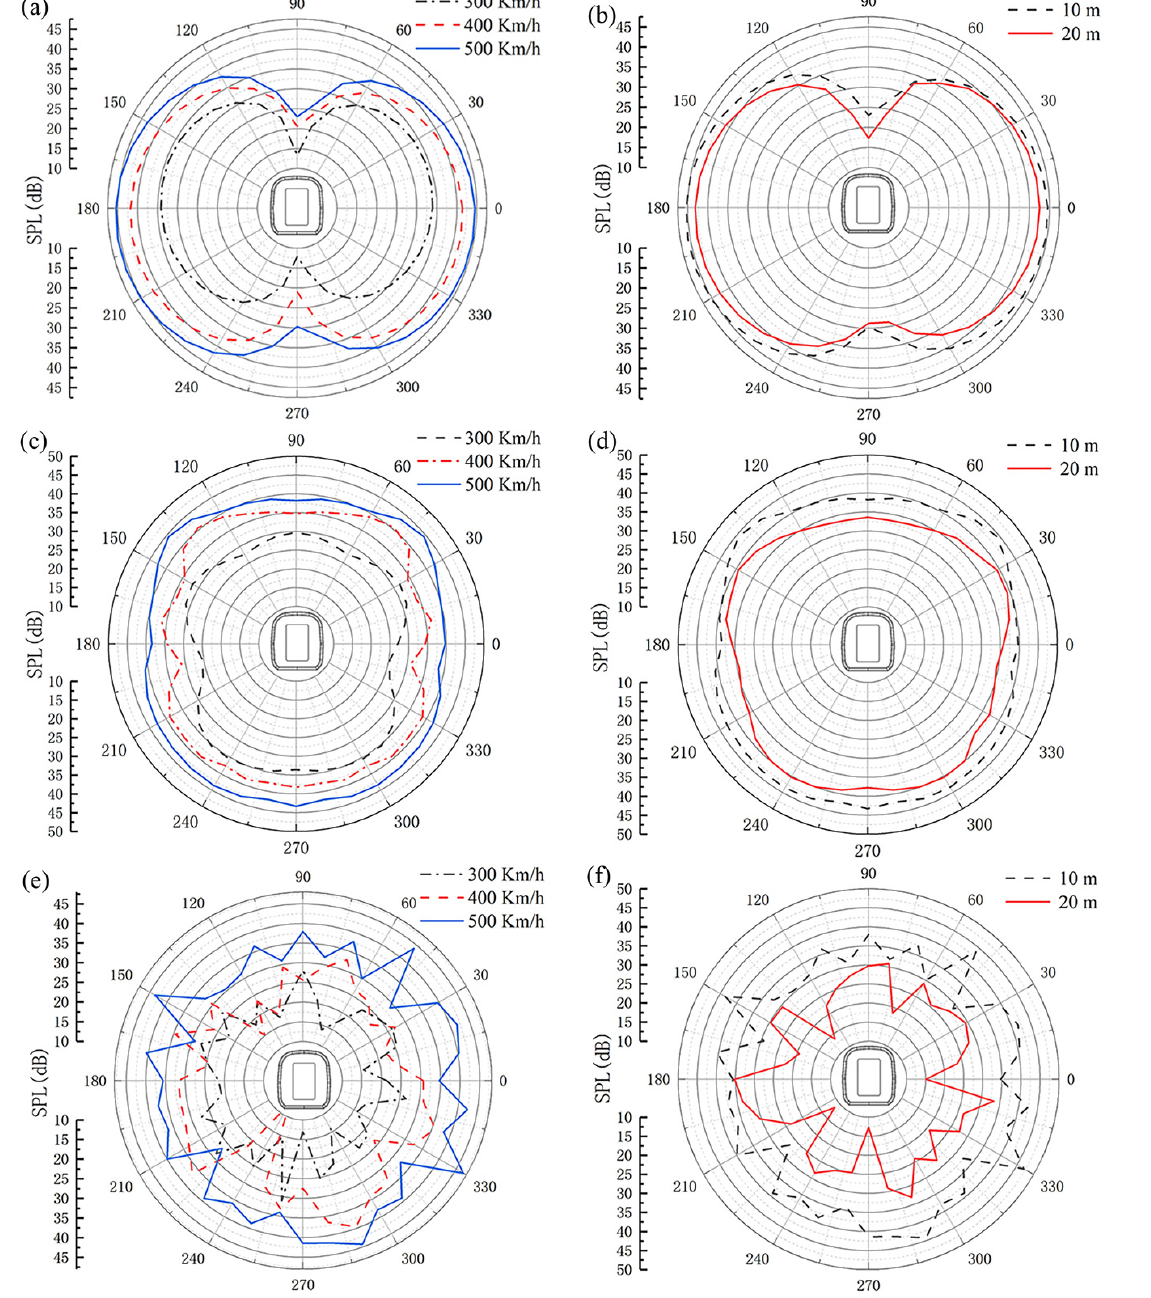
Fig. 13. Aerodynamic noise directivity in windscreen: (a) Different speed noise directivity at 10 Hz (b) Different distance noise directivity at 10 Hz (c) Different speed noise directivity at 100 Hz (d) Different distance noise directivity at 100 Hz (e) Different speed noise directivity at 1000 Hz (f) Different distance noise directivity at 1000 Hz. corresponding SPL decreases with the increase of the dis- that the far-field noise conforms to the law of logarithmic tance between the monitoring point and the vehicle surface. When the monitoring point is close to the vehicle surface, the SPL decreases greatly and slowly with the increase of distance. The R 2 values are all greater than 0.9, indicating